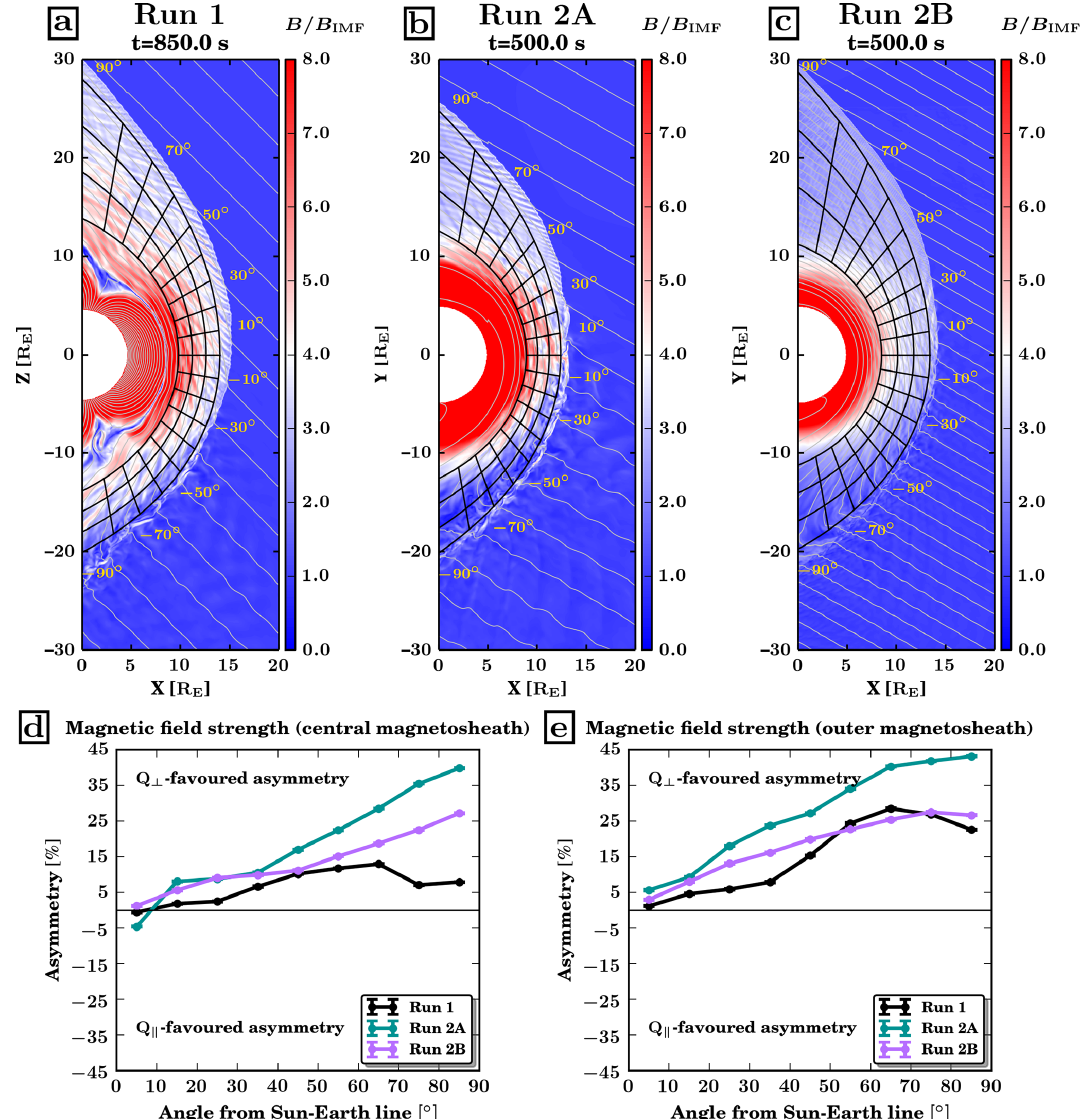
Figure 1. (a–c) Magnetic field strength in the simulation plane, normalised with the IMF strength, in Run 1 at time t = 850s (a) and in Run 2A (b) and 2B (c) at time t = 500s. The light grey lines show magnetic field lines. The spatial bins used to calculate the average magnetosheath parameters are shown in black. (d, e) Magnetic field strength asymmetry in the central (d) and outer (e) magnetosheath. The error bars are obtained from the extreme values of the asymmetry based on the standard error of the mean in each bin (see Sect.